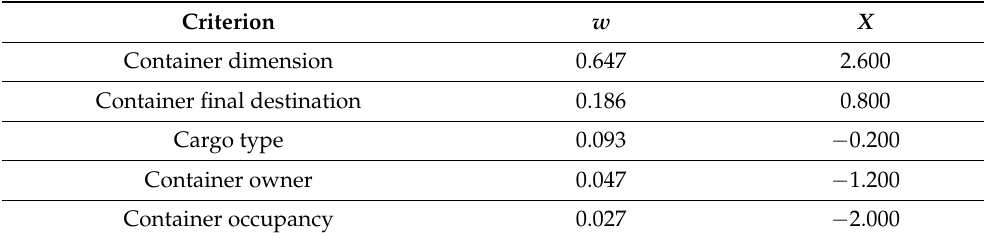
Table 5. Ranking of container storage criteria according to their importance based on decision maker preferences.